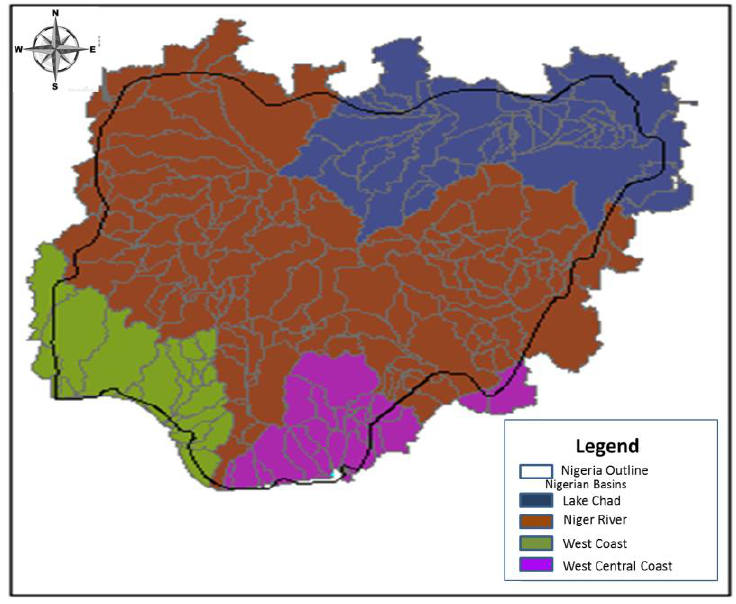
Fig. 2. Basins in Nigeria for water resources of algae production.